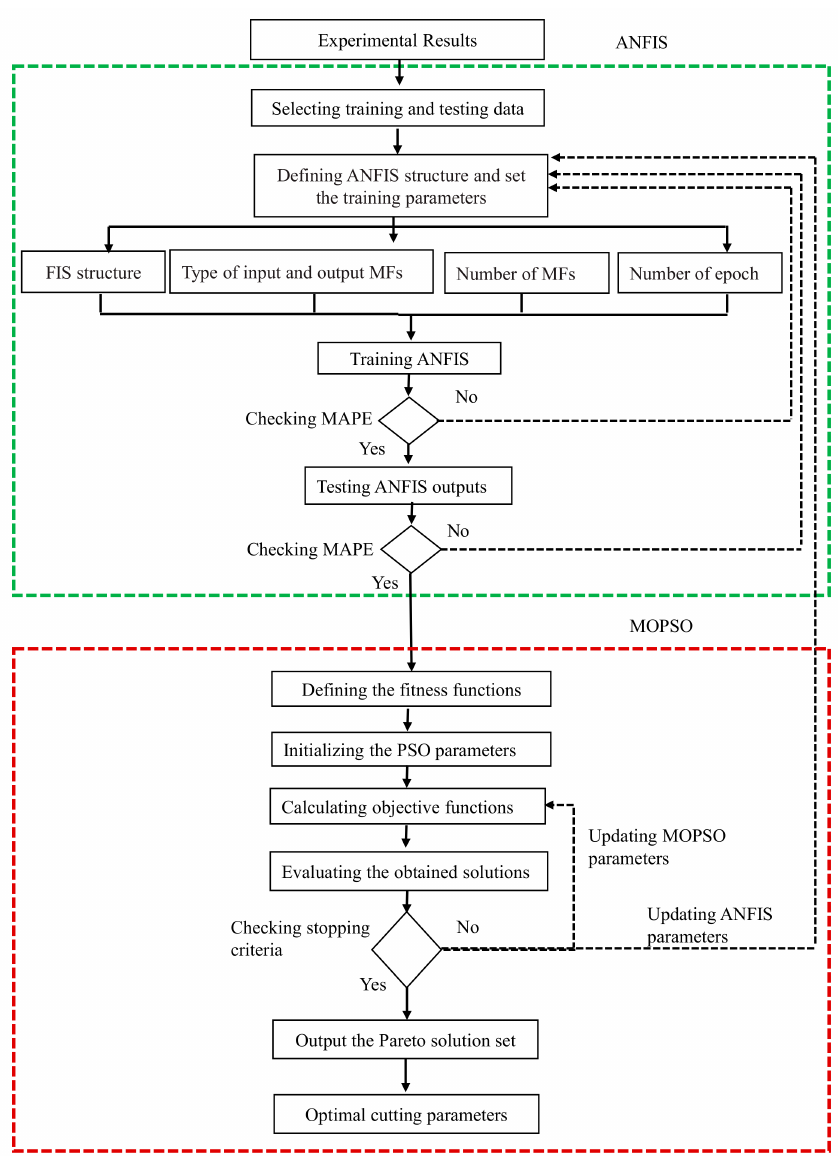
Figure 3. Details of the hybrid approach shown at the following steps: